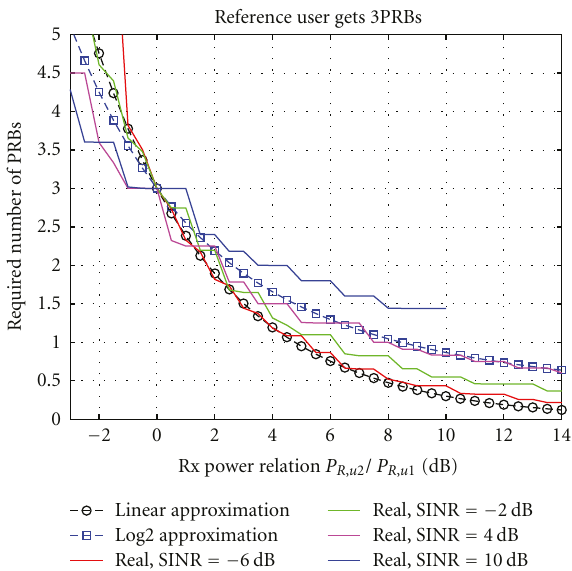
Figure 2: Approximation of required PRBs for throughput fair